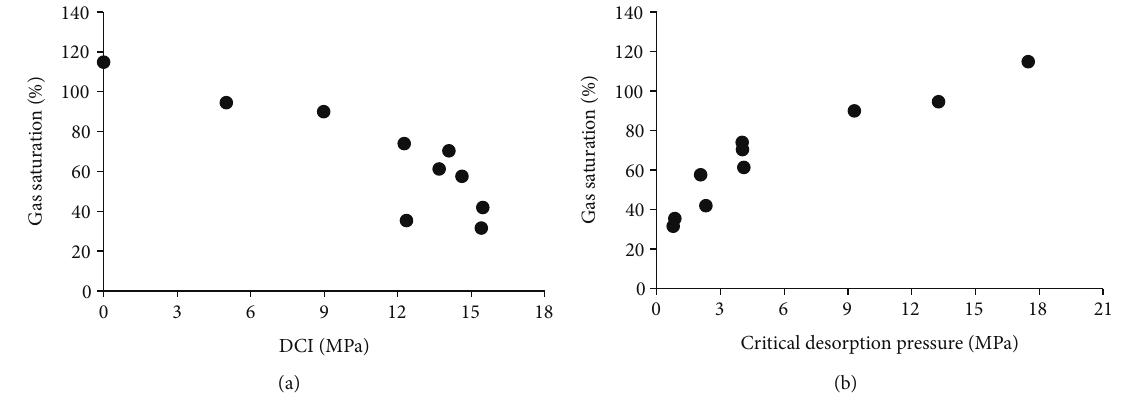
Figure 4: Relationships among gas saturation, DCI, and critical desorption pressure. (a) Gas saturation and DCI. (b) Gas saturation